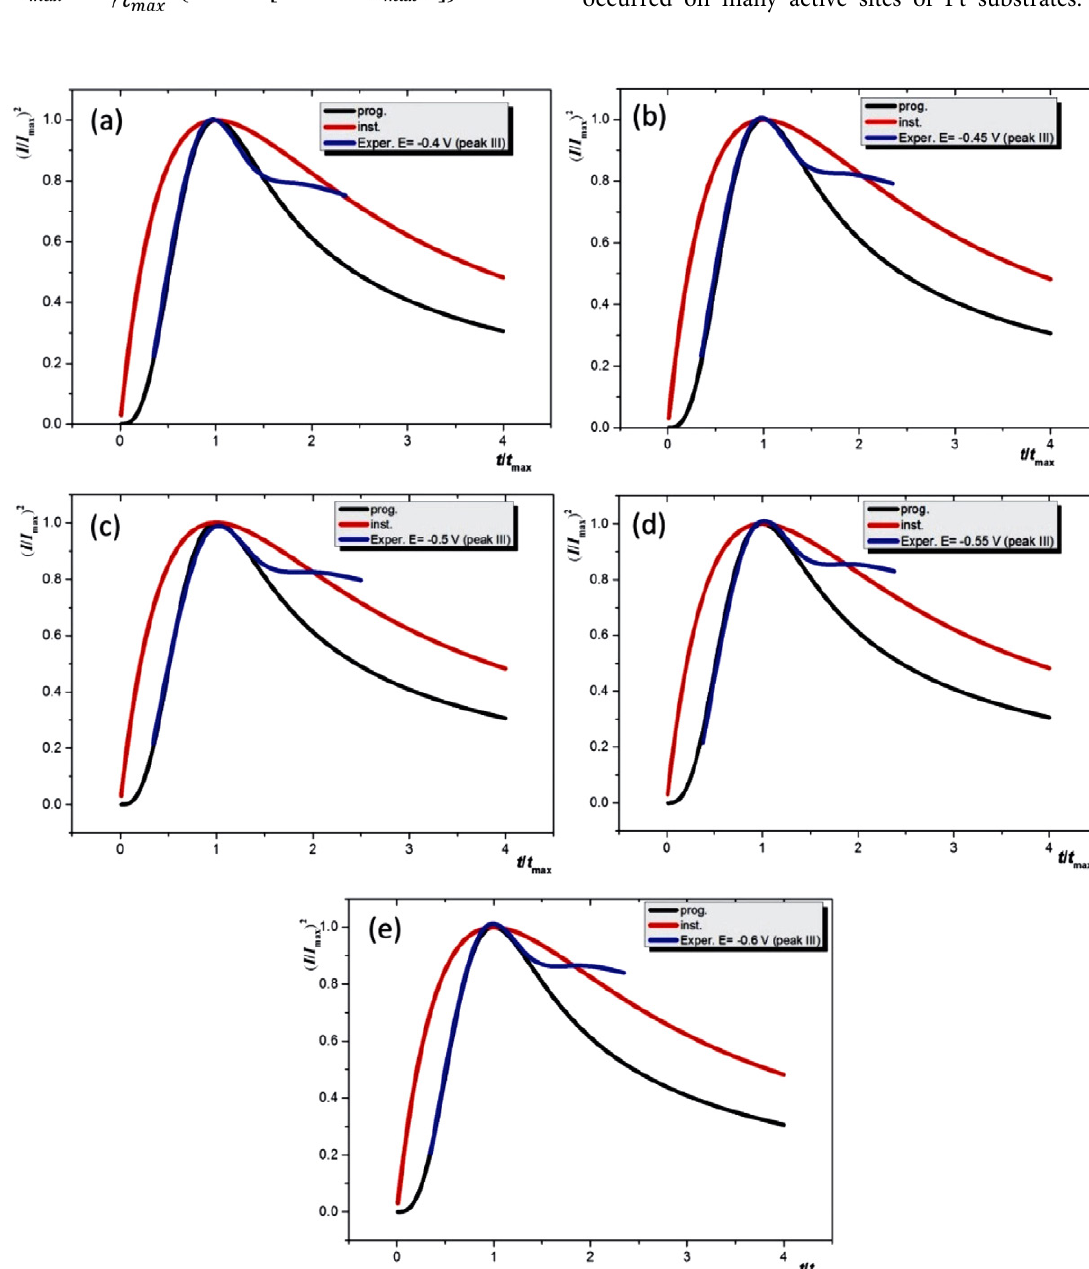
Fig. 7. Comparison of the theoretical non-dimensional (I / I max ) 2 vs (t / t max ) plots for instantaneous (red) and progressive (black) nucleation with experimental data (blue) of potentiostatic transients in the solution of 0.1 Fe(NO 3 ) 3 · 9H 2 O + CH 2 OH-CH 2 OH at different constant potentials: (a) -0.4, (b) -0.45, (c) -0.50, (d) -0.55 and (e)-0.6